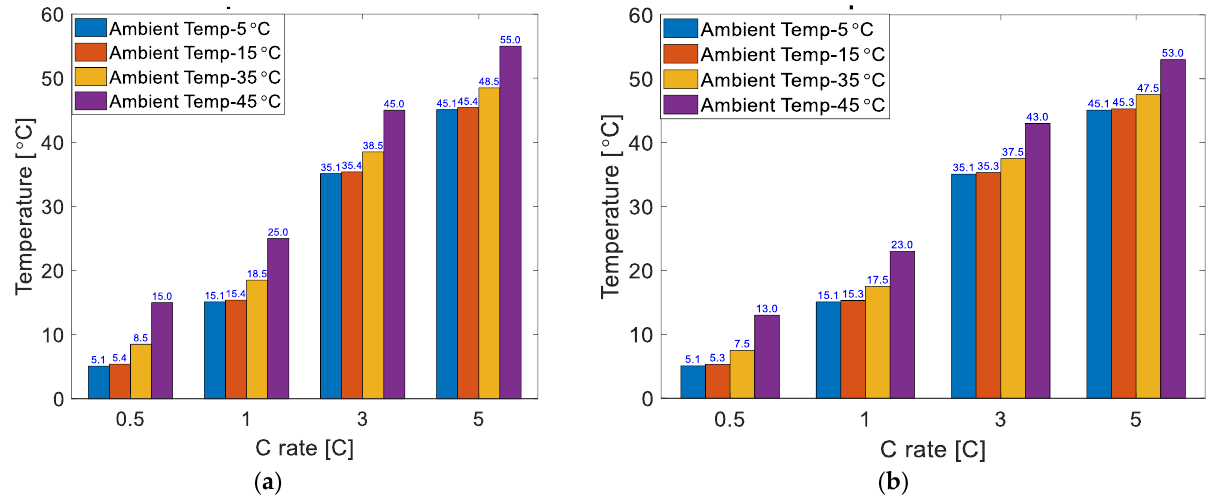
Figure 6. Temperature contours of the entire battery pack in Cu housing with different C rates ( a ) 0.5C ( b ) 1C ( c ) 3C ( d ) 5C while ambient temperature of 45 ◦ C is considered.